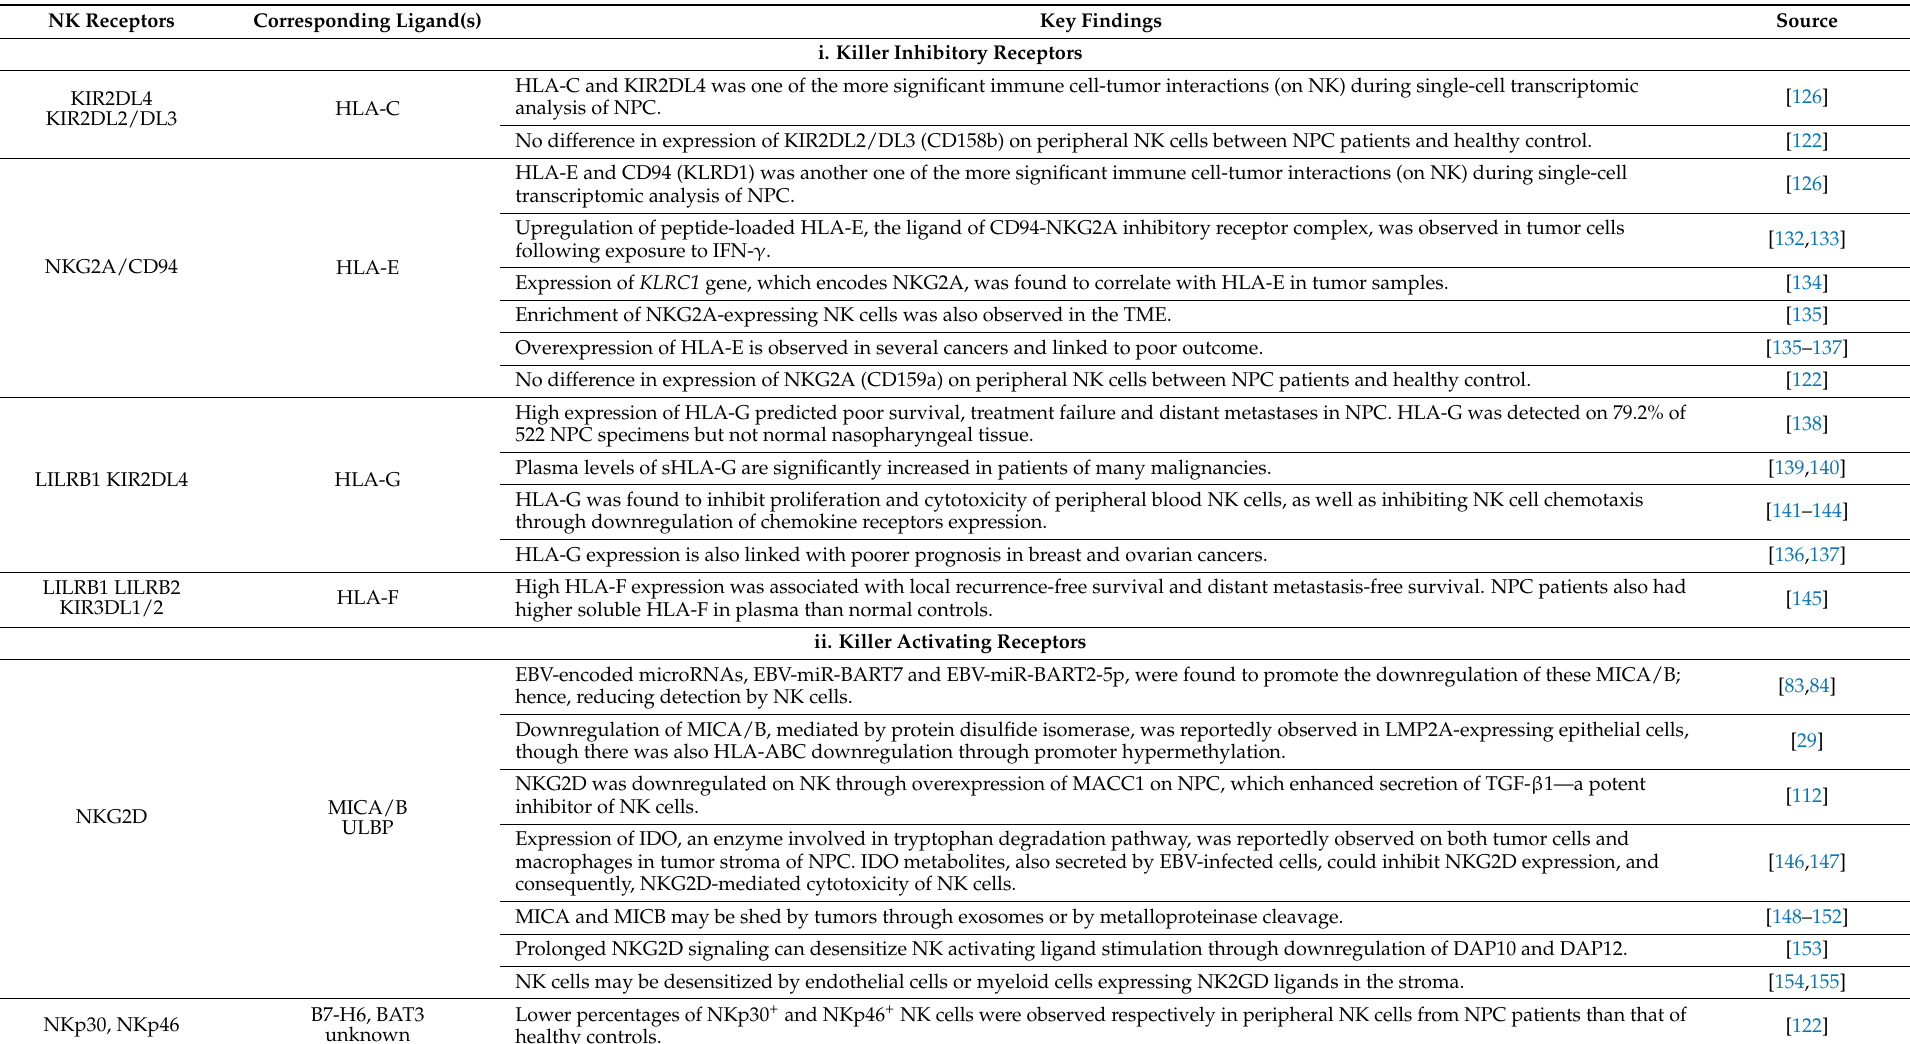
Table 3. Summary of receptor-ligand associated NK immune evasion mechanisms by NPC and other